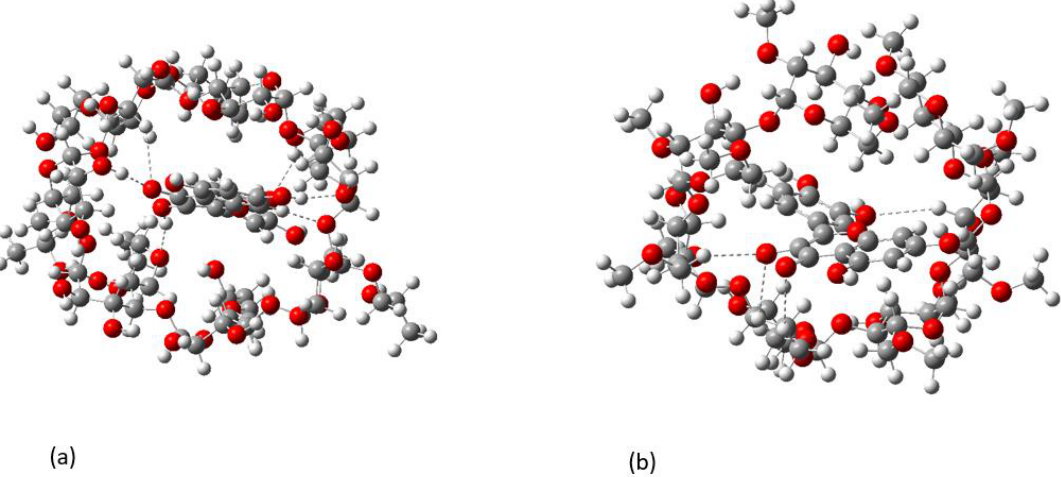
Figure 6. Calculated minimum energy structures: ( a ) QUE (above) and a local minimum of QUE (bottom), ( b ) 2HP- β -CD, c ) 2,6Μe - β -CD, ( d ) complex of QUE with 2HP- β -CD ( d1 ) and complex of reversed QUE with 2HP- β -CD ( d2 ) from two different points of view, and ( e ) complex of QUE with 2,6Μe - β -CD ( e1 ) and complex of reversed QUE with 2,6Μe - β -CD ( e2 ) from two different points of view. All calculations were performed in water solvent using B3LYP/6-31G(d,p). The en- ergy differences between the conformations in complexes are shown for the B3LYP level of theory; energy differences calculated using PM6 are shown in parentheses.